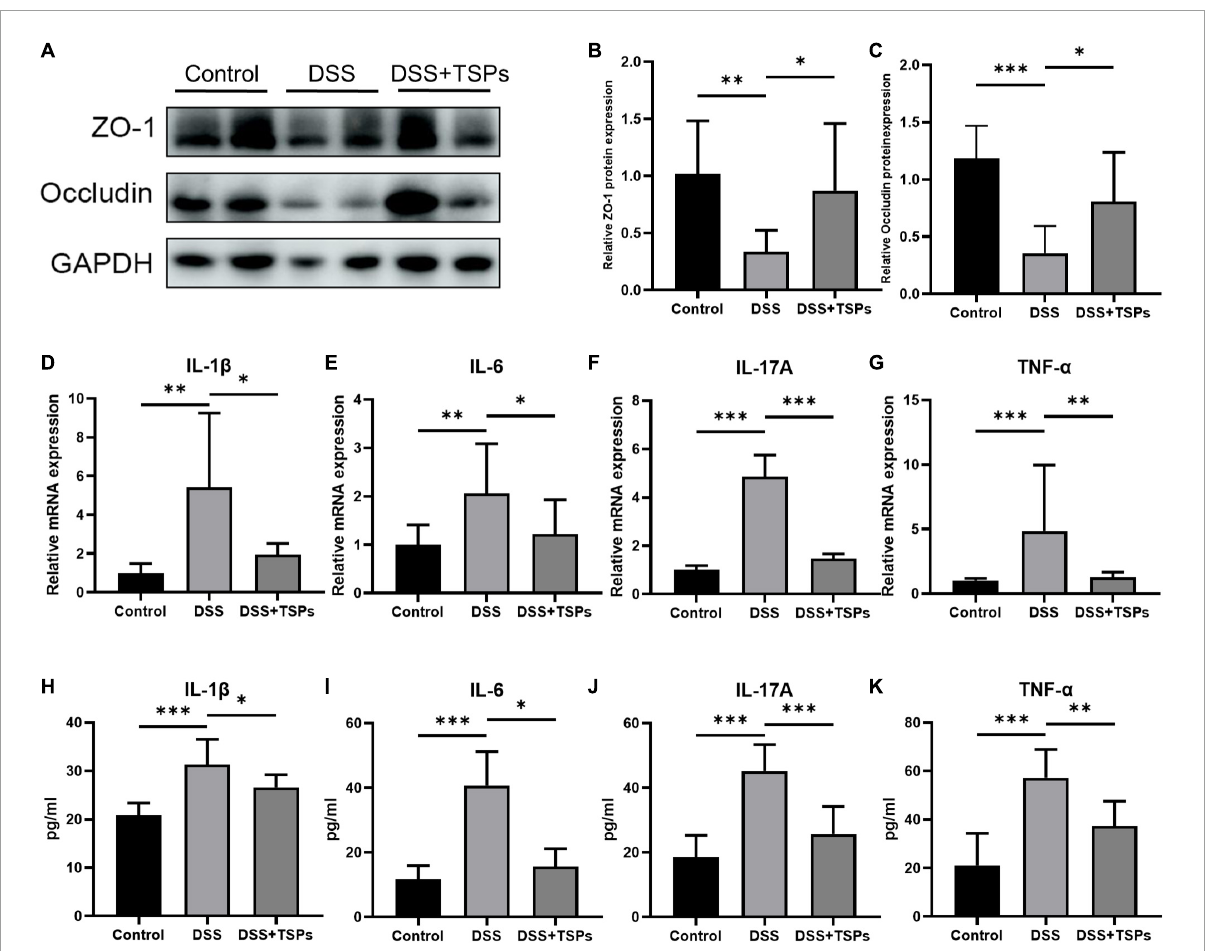
FIGURE6 Oral TSPs improved the mucosal barrier function and inhibited the expression of inflammatory cytokines. (A) Western blot analysis of the tight junction proteins ZO-1, occludin in the colon. Grayscale statistics of ZO-1 (B) and occluding (C) relative to internal control ( n = 8). (D–G) Relative mRNA expression of pro-inflammatory cytokines, IL-1 β , IL-6, IL-17A and TNF- α ( n = 8). The concentrations of IL-1 β (H) , IL-6 (I) , IL-17A (J) and TNF- α (K) measured by ELISA in the colon ( n = 8). Data were presented as means ± SD. Statistical significance was determined using one-way ANOVA. ∗ P < 0.05, ∗∗ P < 0.01, ∗∗∗ P <